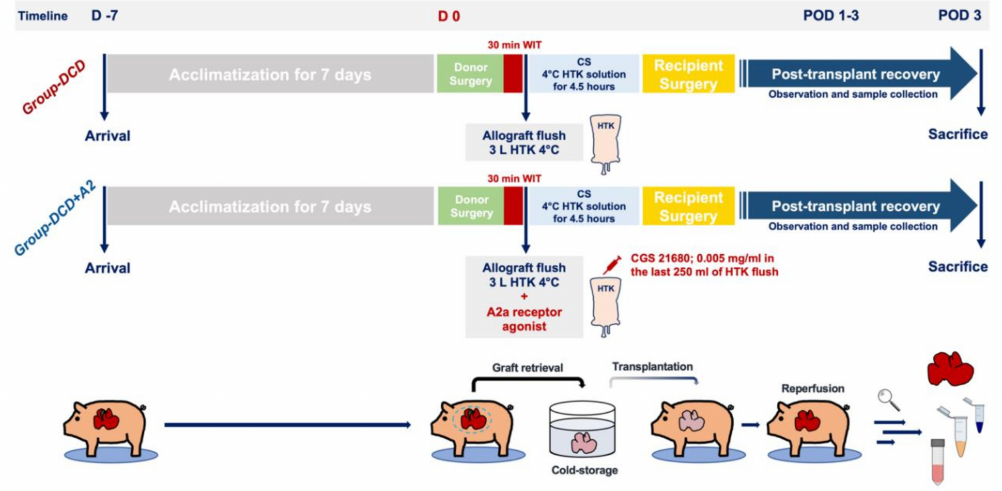
Figure 6. Study flowchart and surgical protocols. Animals were randomized into two experimental groups (DCD and DCD + A2). Following a 7-day acclimatization period in our housing facility, a liver graft from the donor animal was retrieved and implanted into the recipient animal following 30 min of circulatory death / in situ warm ischemia and 4.5 hours of cold preservation. Liver grafts in the DCD + A2 group were flushed with a standard dose of CGS 21680 adenosine A2a receptor agonist added to the HTK solution. Animals were monitored closely and sacrificed after 3 days of reperfusion for sample collection and further analysis ( n = 5 / group). Abbreviations used: DCD—donation after circulatory death; HTK—histidine-tryptophan-ketoglutarate solution; POD—postoperative day; CS—cold storage; WIT—warm ischemia